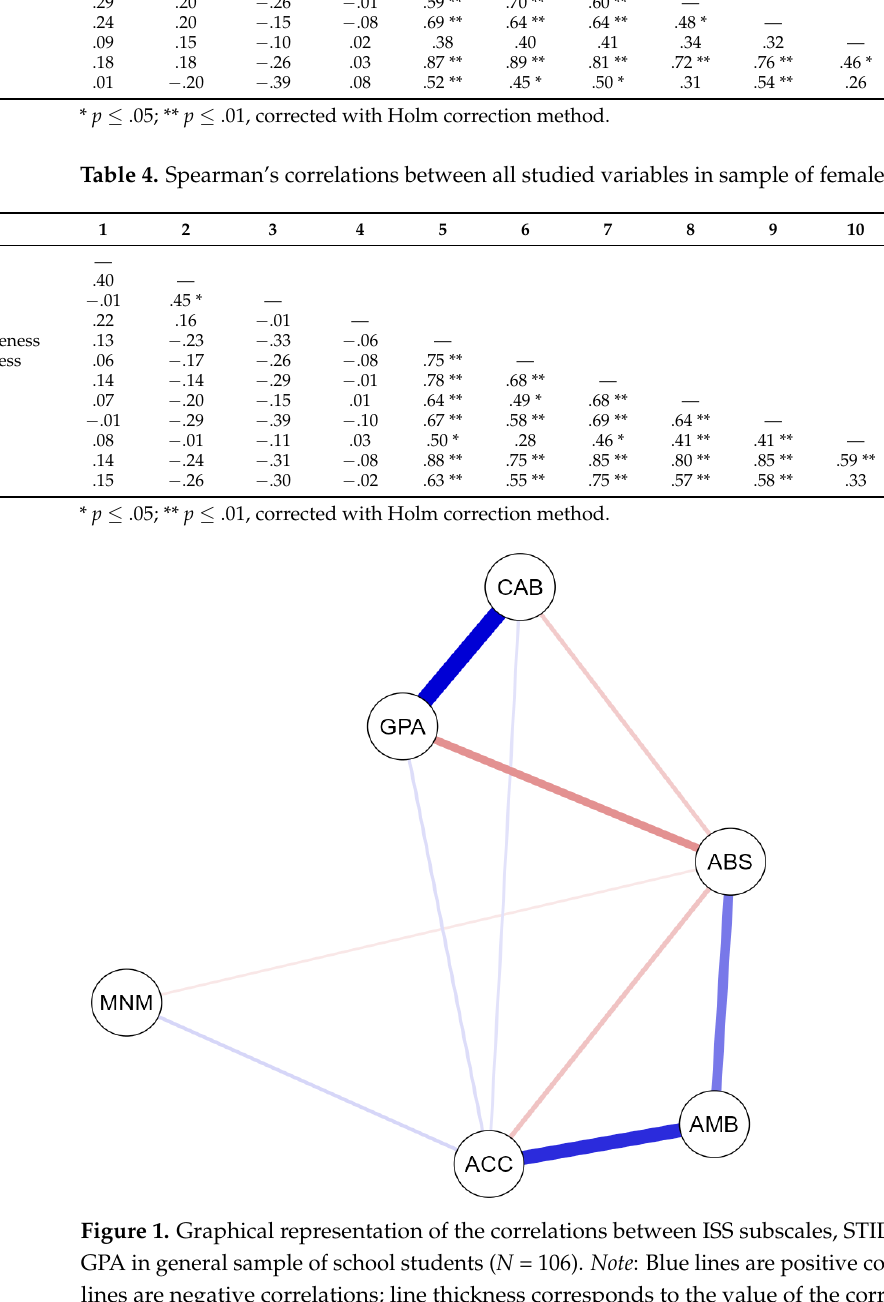
Table 3. Spearman’s correlations between studied variables in the sample of male school students ( N = 51). Variables